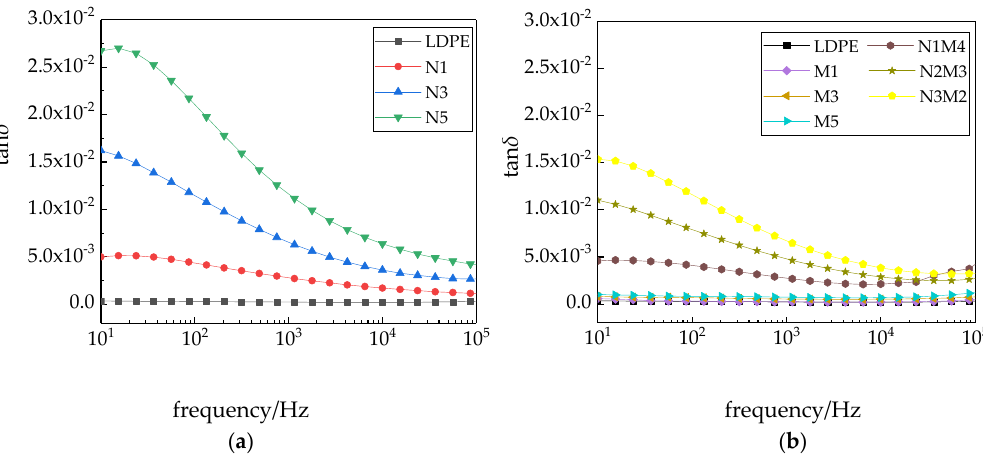
Figure 9. Variation in the dissipation factors of different samples with the frequency: ( a ) LDPE and nano-ZnO/LDPE samples; ( b ) micro ZnO/LDPE and micro-nano-ZnO/LDPE samples.